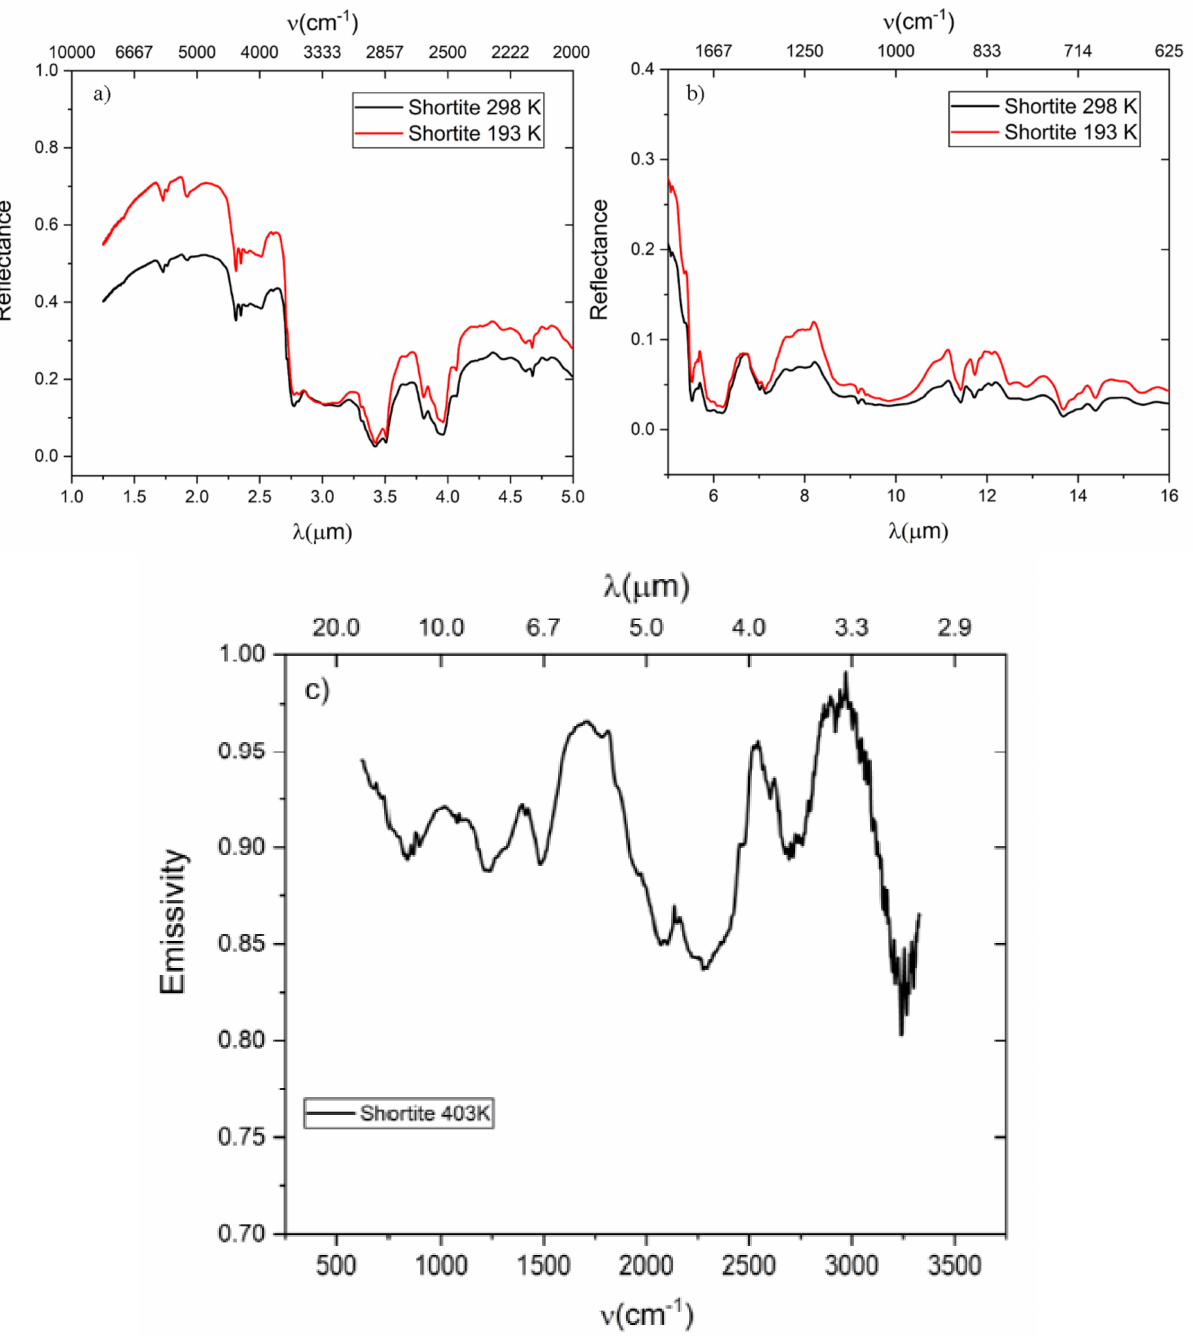
Figure 6. Reflectance spectra at room temperature and 193 K ( a , b ) and emissivity measurements at 403 K ( c ) of